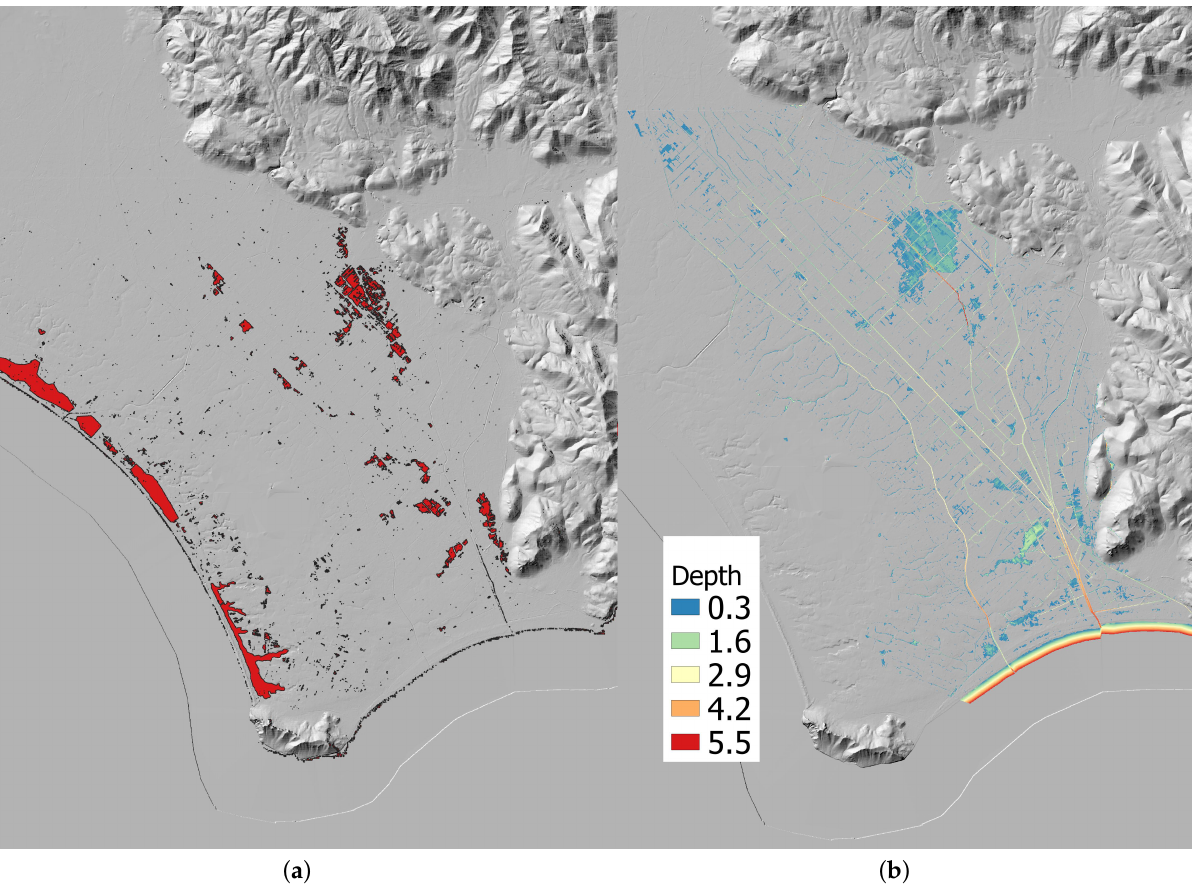
Figure 7. Comparison between flooding areas by Sentinel 1 satellite image ( a ) and simulated ones ( b